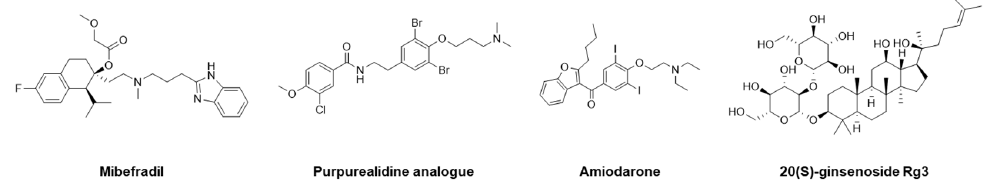
Figure 1. Structures of known ligands binding to the voltage ‐ sensor domain of K V 10.1.